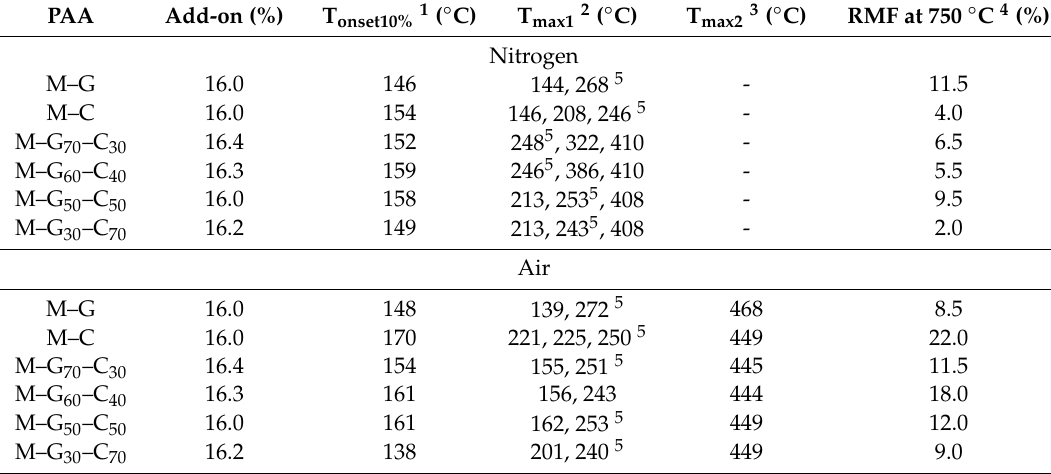
Thermal data of homopolymeric and copolymeric PAAs in nitrogen and air by thermogravimetric